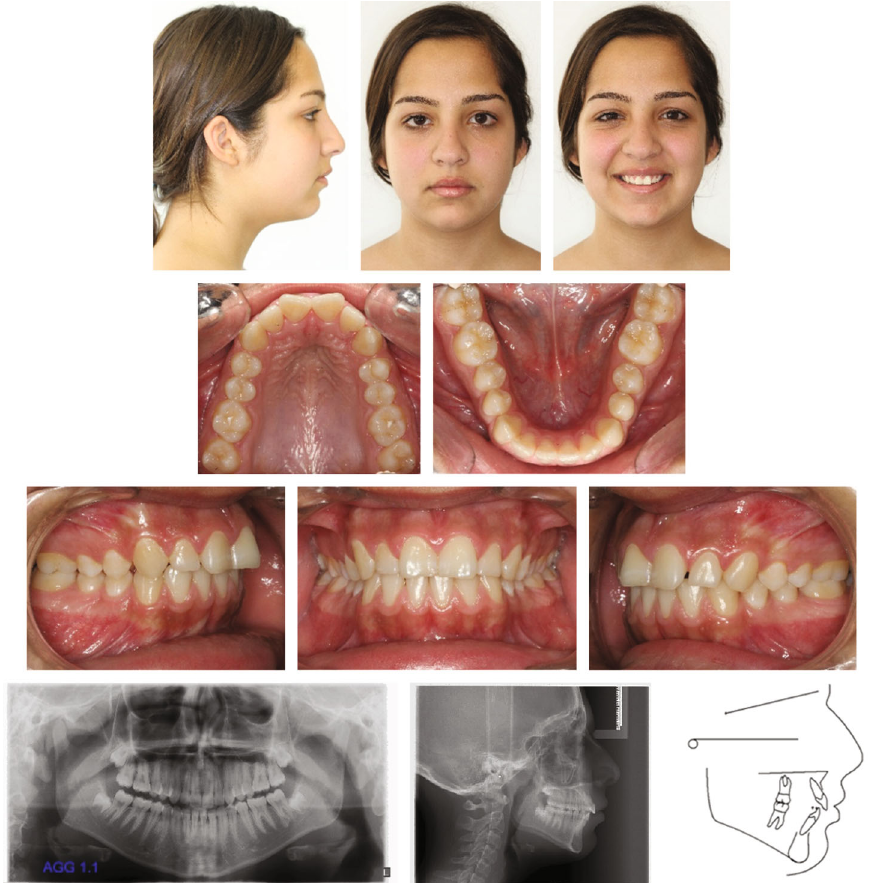
Figure 6: Case 1. 15-year-old female patient with a class II molar relationship subdivision right, shifted maxillary midline, and slightly proclined upper and lower incisors before